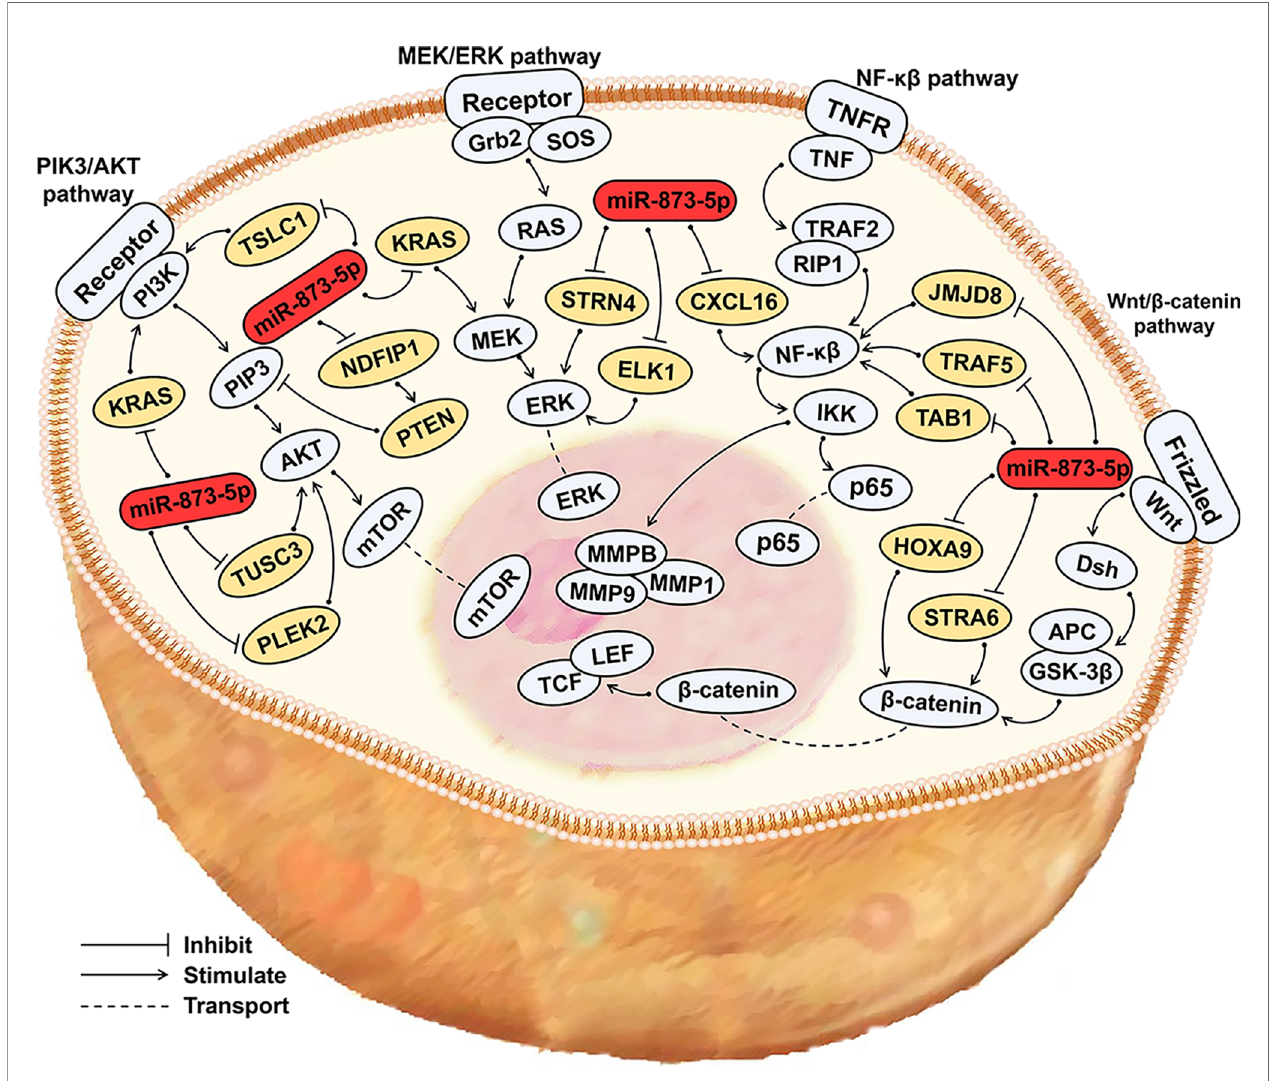
FIGURE 3 | miR-873-5p related signaling pathways in cancer. miR-873-5p can in fl uence cancer development by participating in the PIK3/AKT/mTOR, Wnt/ b - Catenin, NF- kb , MEK/ERK signaling pathways. Blue, signaling pathway; Orange, target gene; Red,